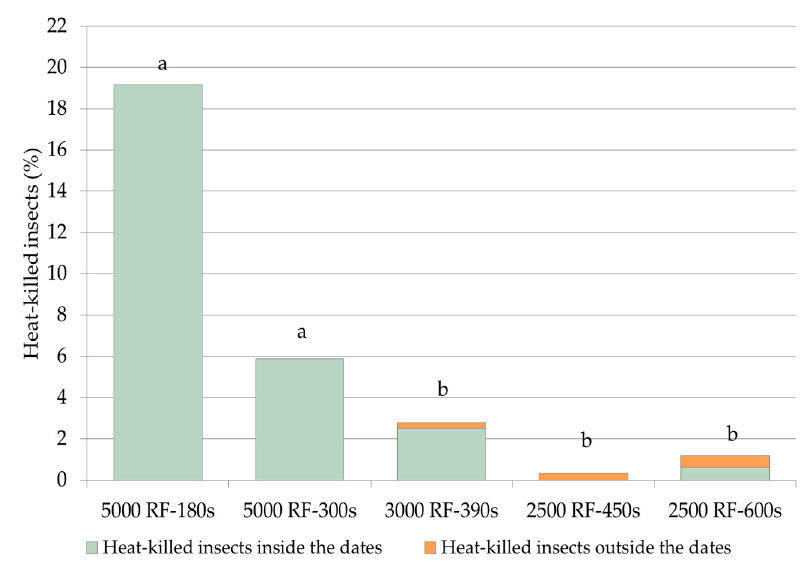
Figure 2. Mortality of C. hemipterus adults in the experiments where heat-killed individuals occurred (percentages calculated on the overall number of insects of each experiment). Different letters above the columns indicate significant differences (Chi-square test of independence, χ 2 = 88.4732; df = 4; p < 0.0001, followed by Marascuilo test to compare proportions; p < 0.05).